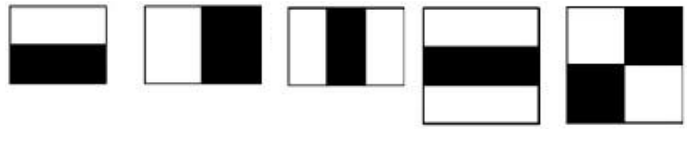
Figure 7. Haar features.